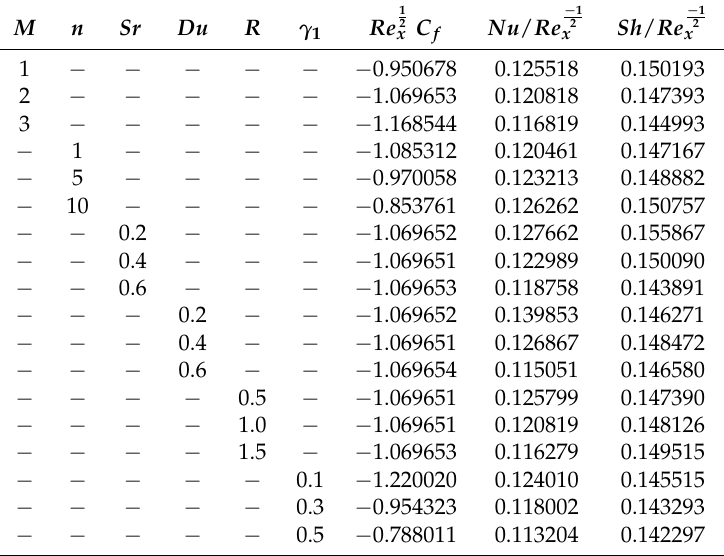
Table 4. Variations in C f , Nu x and Sh x for the suction case.